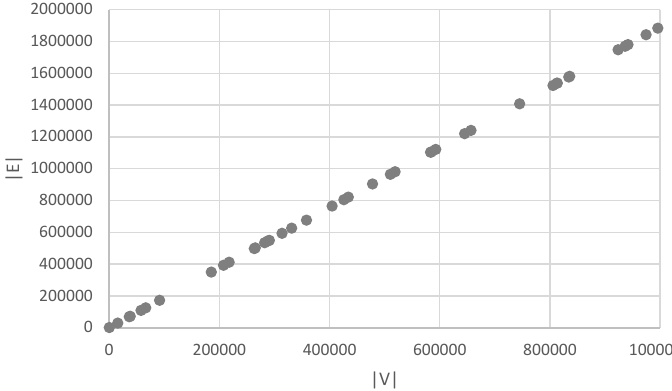
Figure 5. The number of edges required to obtain almost all possible